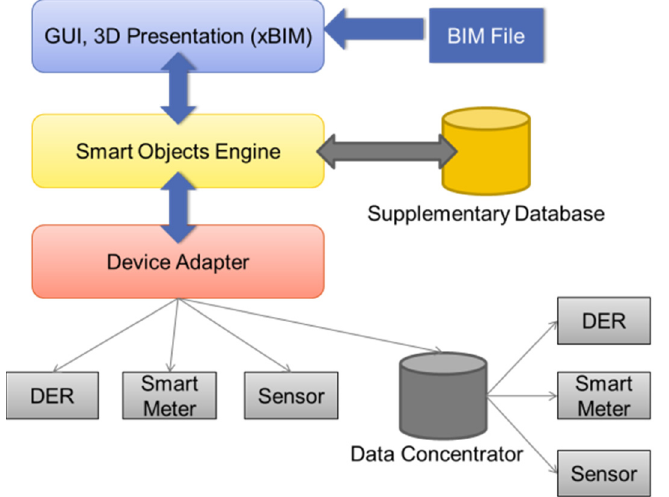
Figure 9. BIM-based energy management platform software architecture. DER, distributed energy